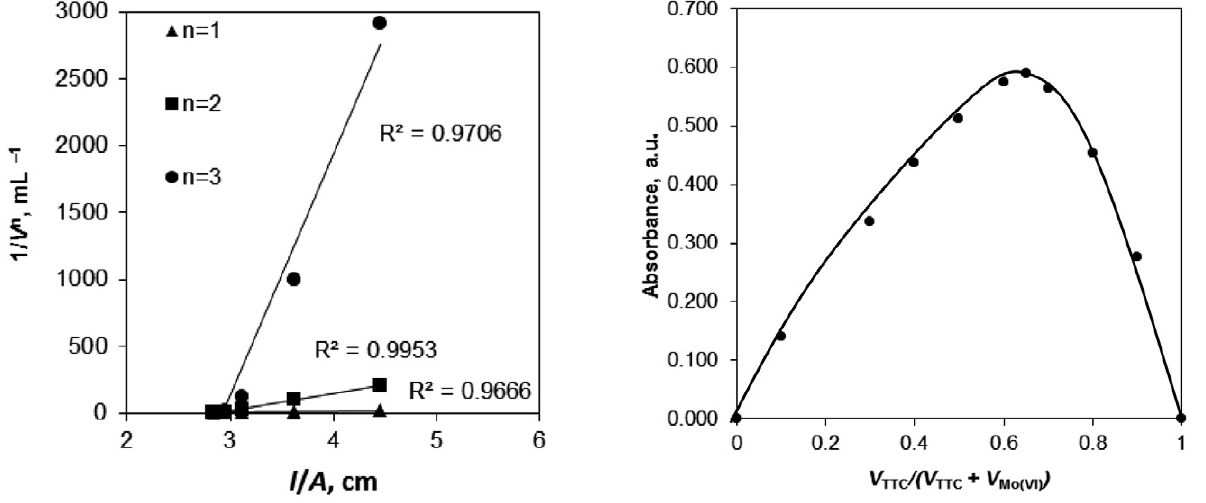
Figure 4. Determination of the molar ratio (n) Mo(VI):TTC by the method of Asmus C Mo(VI) = 1.6 × 10 ‒5 mol L –1 ; C 3,5-DNC = 1.2 × 10 ‒3 mol L –1 ; C H2SO4 = 4.5 × 10 –1 mol L –1 ; λ = 410 nm; τ = 3 min